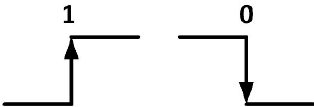
Figure 3. Differential Manchester encoding.